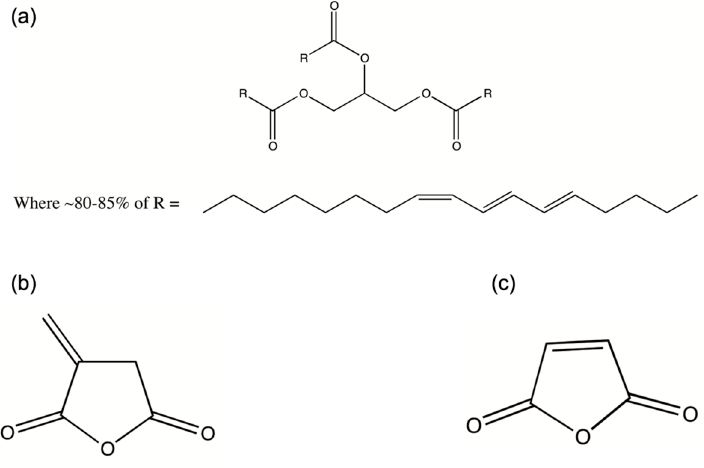
Figure 1. Chemical structures of ( a ) tung oil, ( b ) itaconic anhydride, and ( c ) maleic